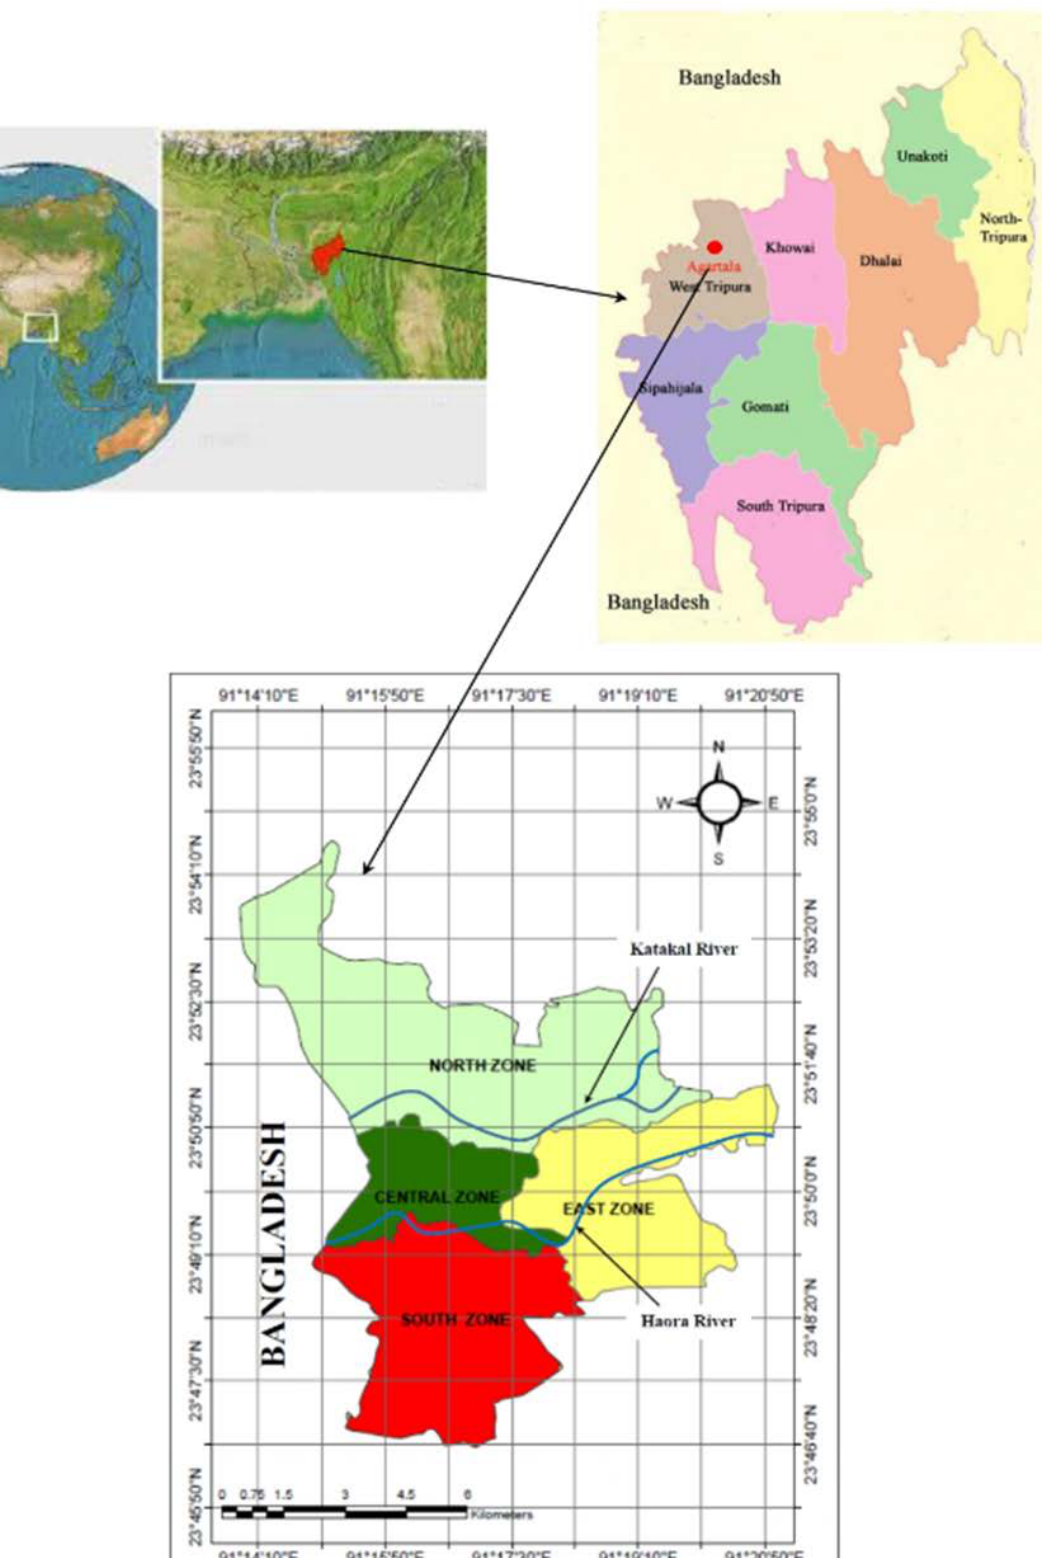
Figure 1. Location maps for the Agartala study area, located in the north-eastern part of